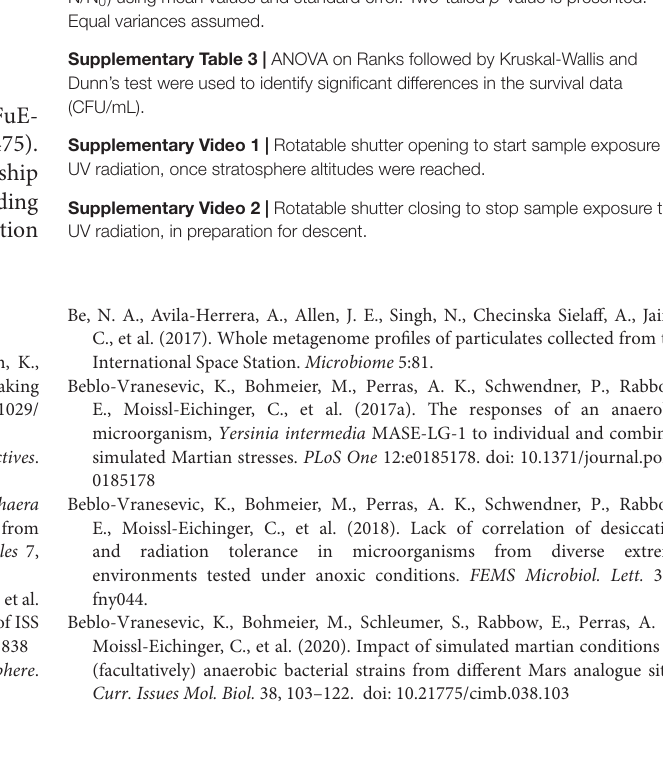
Supplementary Table 1 | Student’s t -test was used to identify significant differences between two tested conditions of the survival data using raw data (CFU/mL). Two-tailed p -value is presented. Equal variances assumed. Supplementary Table 2 | Student’s t -test was used to identify significant differences between two tested conditions of the survival data (Survival Fraction N/N 0 ) using mean values and standard error. Two-tailed p -value is presented. Equal variances assumed. Supplementary Table 3 | ANOVA on Ranks followed by Kruskal-Wallis and Dunn’s test were used to identify significant differences in the survival data